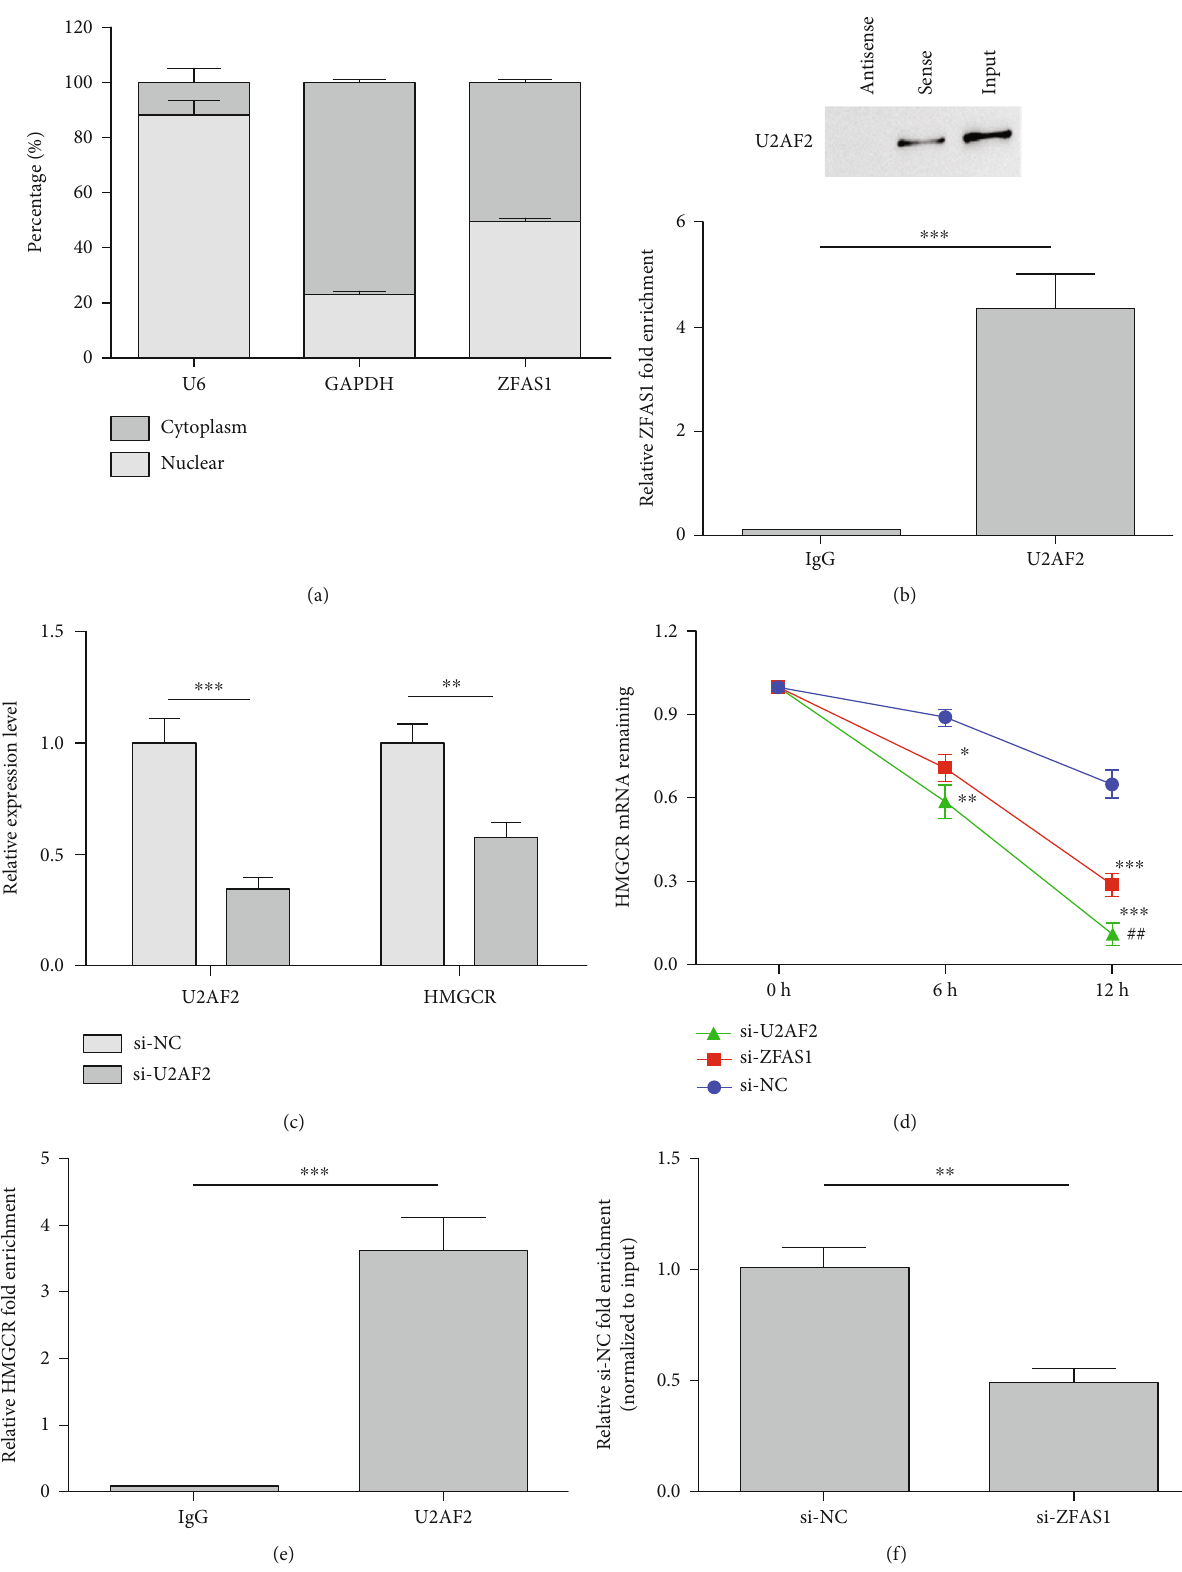
Figure 4: ZFAS1 maintains HMGCR mRNA stabilization by binding to U2AF2. (a) ZFAS1 distribution in BxPC-3 cells; (b) immunoprecipitation protein levels and RIP assay; (c) U2AF2 and HMGCR expression detected by qRT-PCT; (d) HMGCR mRNA stabilization; (e) HMGCR fold enrichment in U2AF2 relative to IgG; (f) qRT-PCR analysis of HMGCR in RIP experience; ∗ P < 0 : 05 ; ∗∗ P < 0 : 01 ; ## P < 0 : 01 ; ∗∗∗ P < 0 : 001